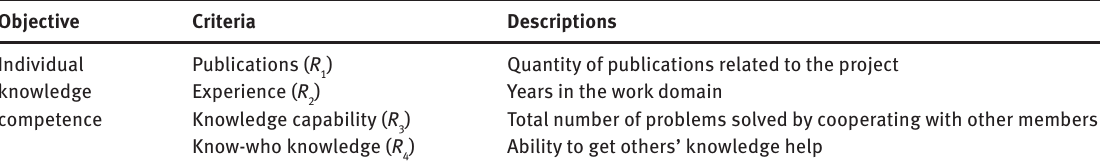
Table 1: Criteria for Individual Knowledge Competence Objective